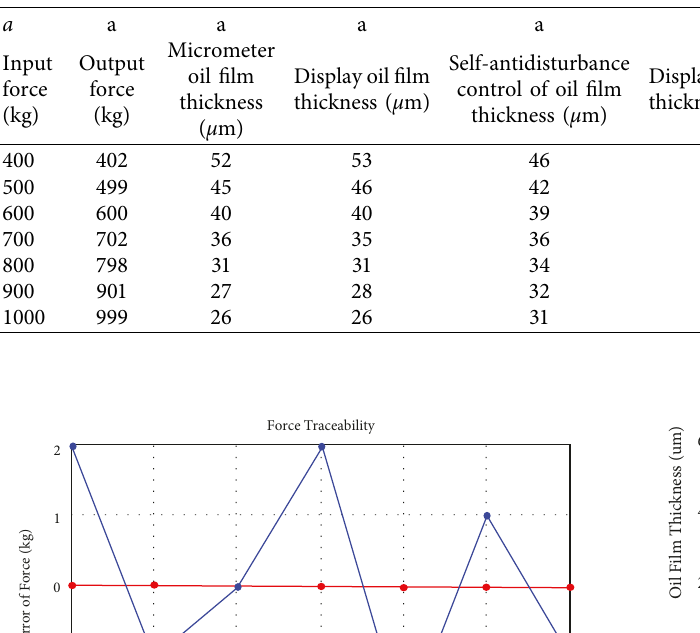
Figure 38: General assembly of the test bench. Table 2: Testing experimental values.